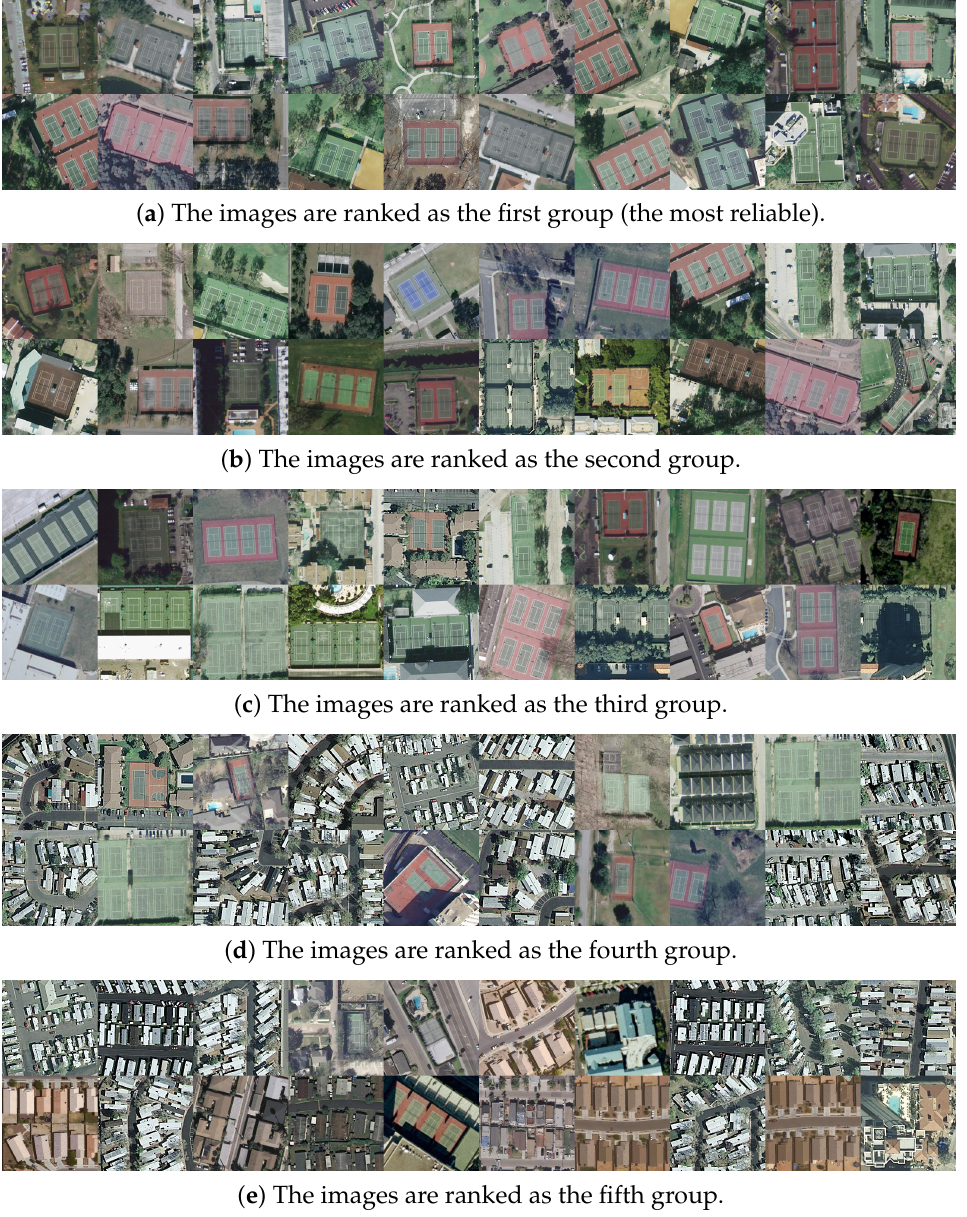
Figure 6. In the first group, that is the most reliable group of images containing a tennis court, all the images are correctly clustered. The images ranked in the second and third group are also all correctly clustered. In the fourth group, there are 1 image of dense residential, 11 images of mobile home parks, and 8 images of tennis courts. In the last group, there are only 3 images of tennis